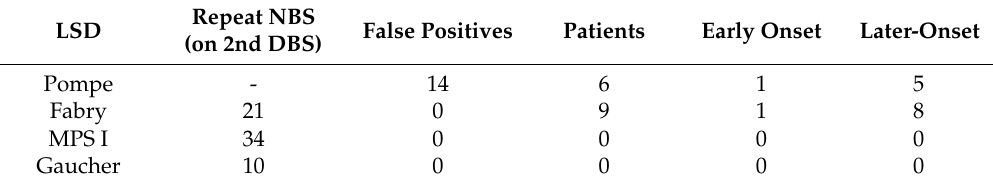
Table 1. Overall screening